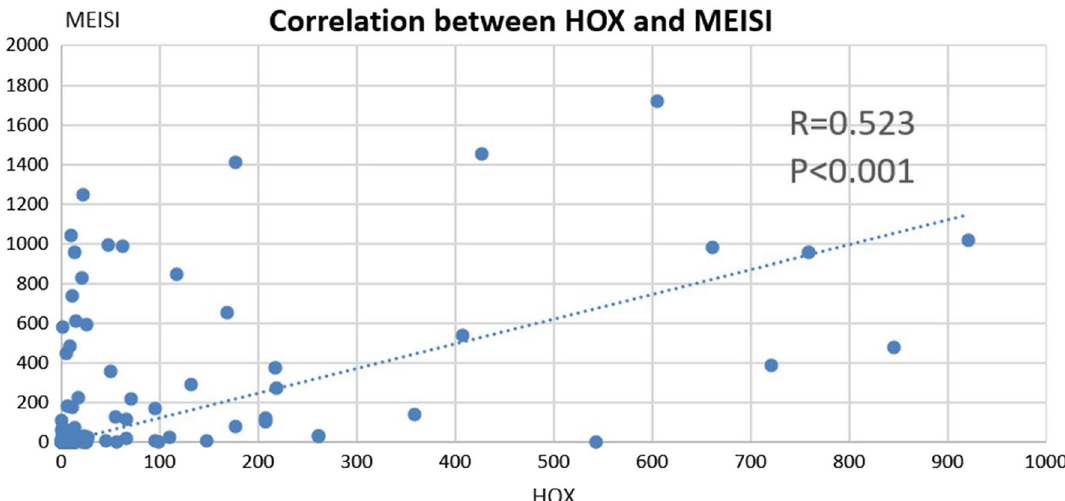
Fig. 4 Correlation between HOXA9 and MEIS1 genes